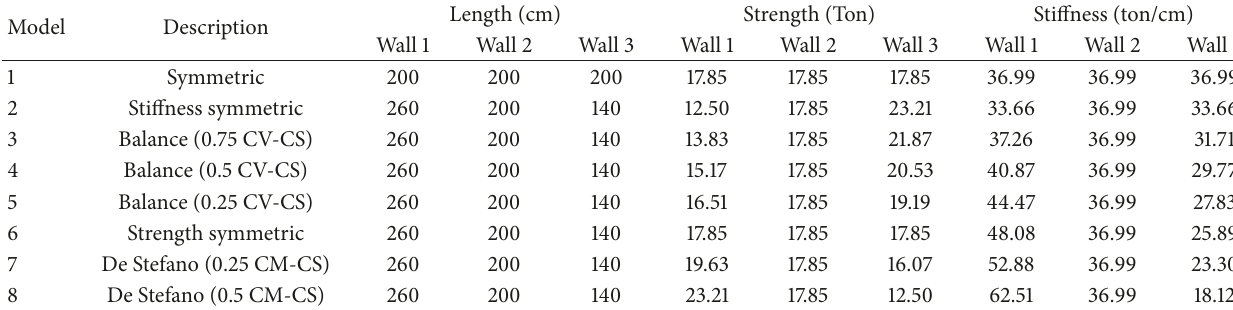
Table 1: Strength and stiffness of LLREs in analytical models.